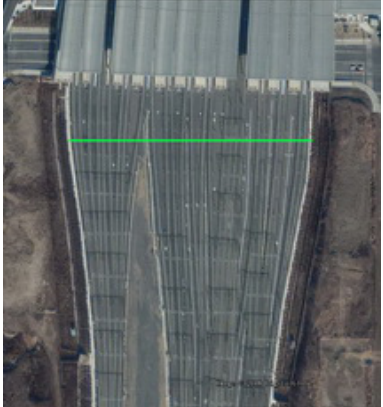
Figure.4 Location of the elevation profile in Google-earth